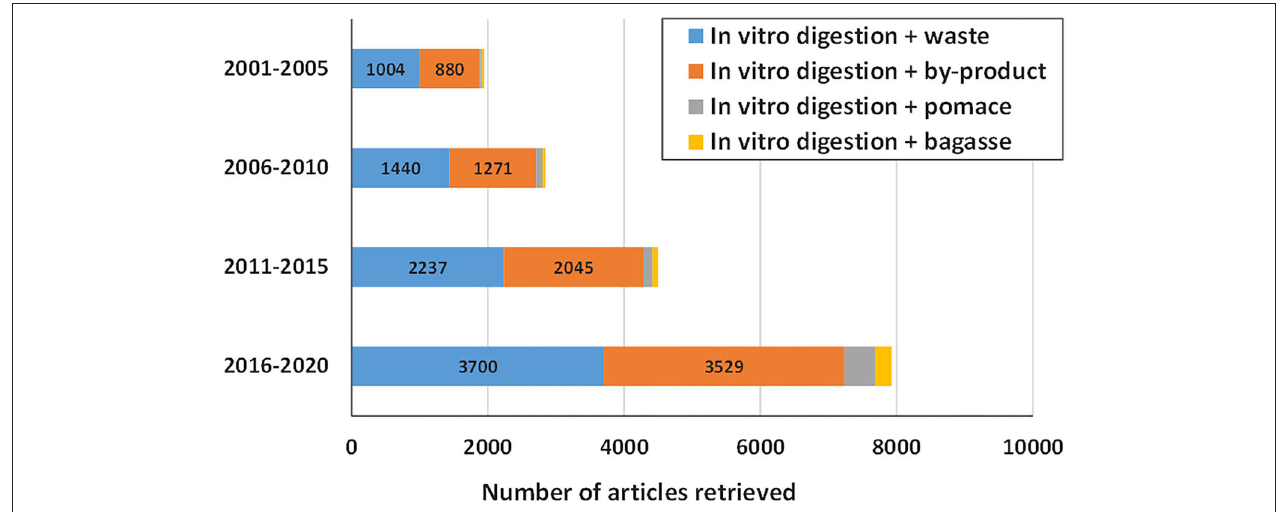
FIGURE 3 | Evolution in the number of published articles (retrieved by Science Direct) which combine the keywords “ in vitro digestion” and “waste,” “by-product,” “pomace,” or “bagasse,” in the last 20 years.